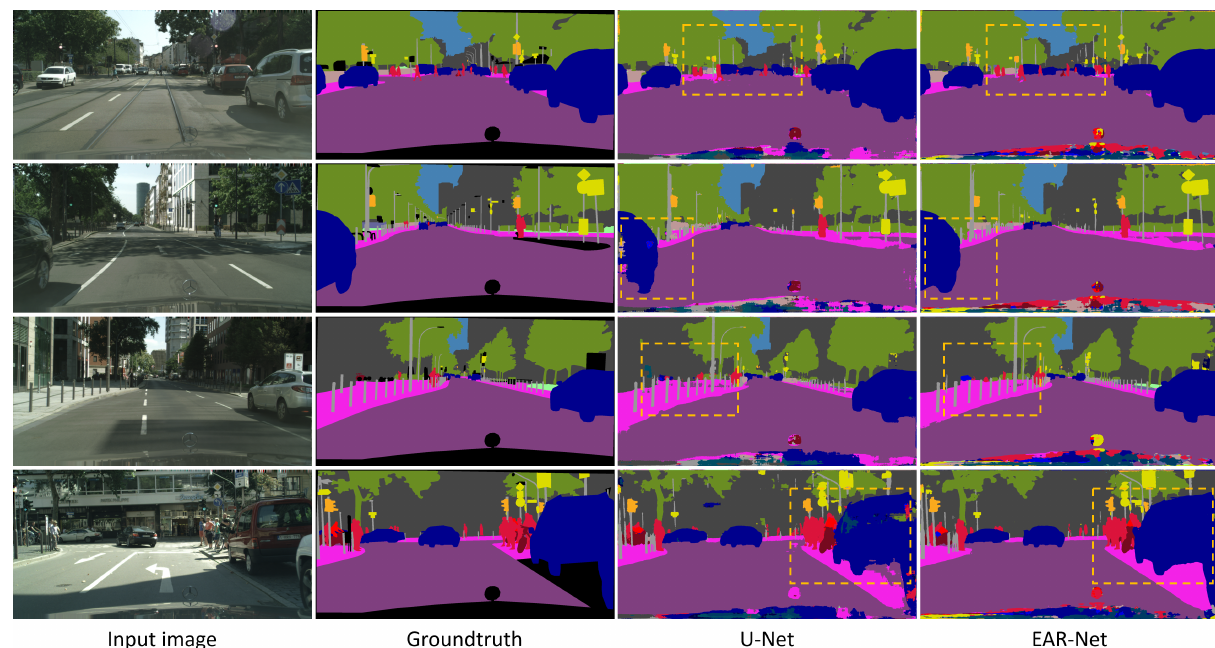
Figure 8. Visual comparisons of complex scenes on the Cityscapes validation set. The orange box shows the section where the EAR-Net achieves a more accurate segmentation result than the U-Net.